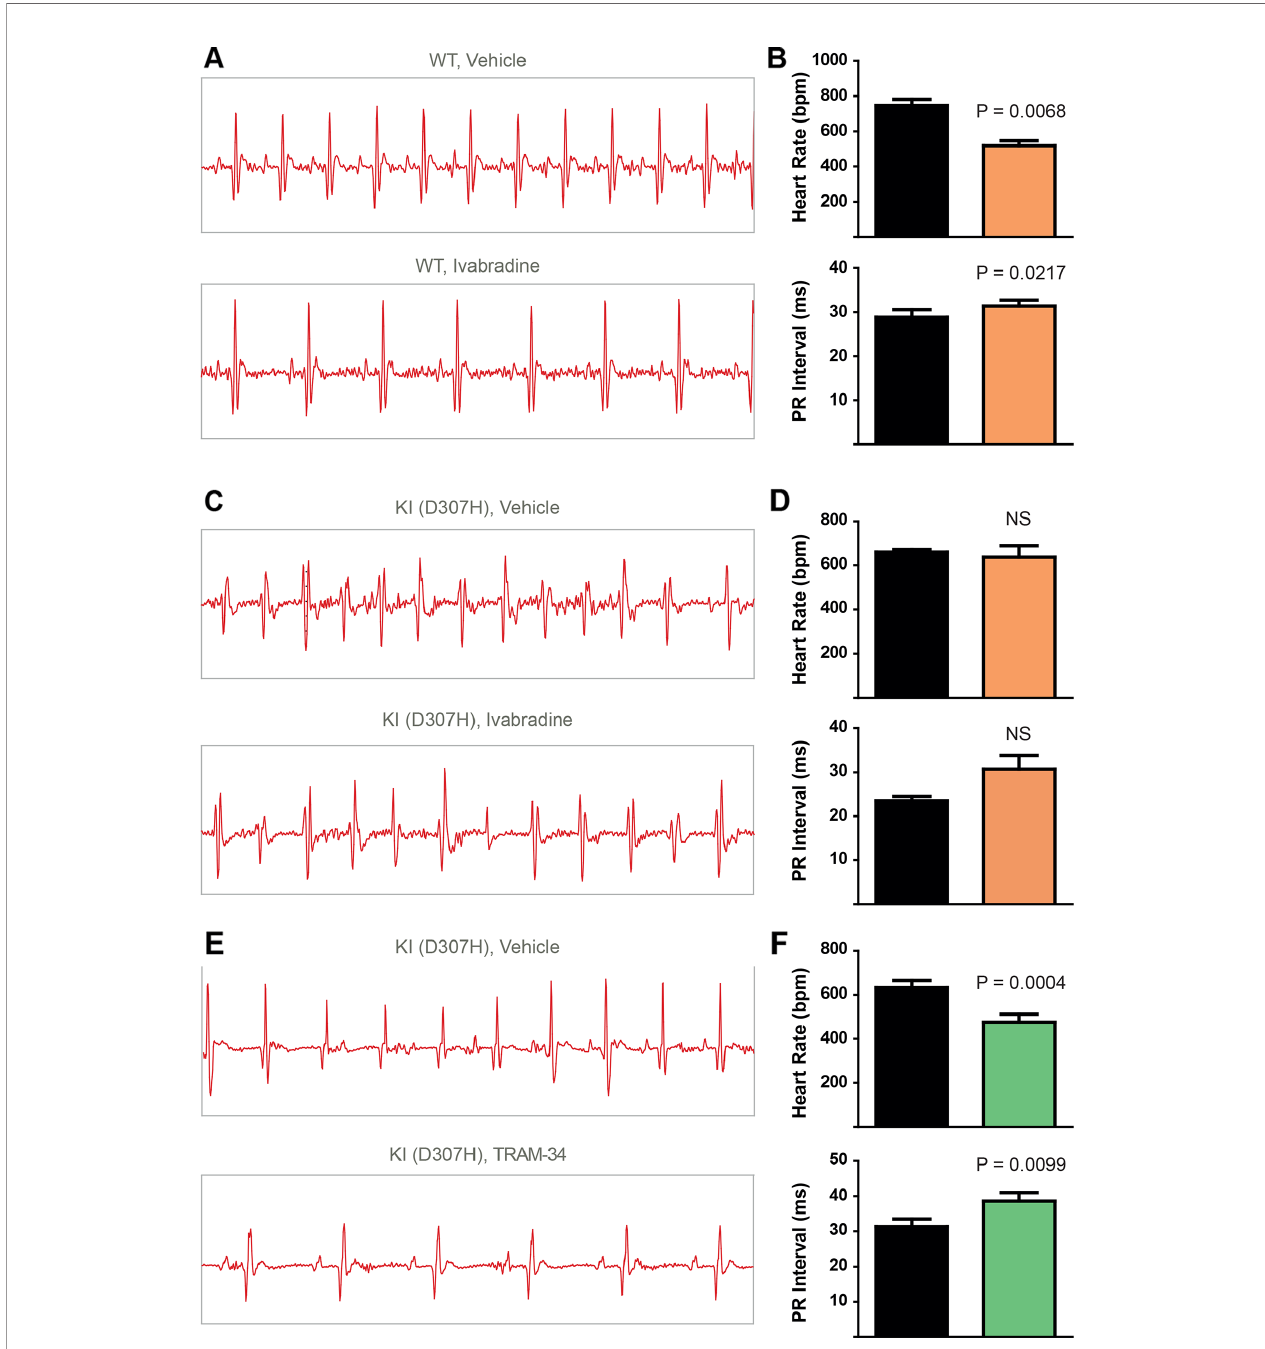
FIGURE 4 | In contrast to TRAM-34, ivabradine does not prevent the ventricular arrhythmias recorded in ECG from CASQ2 D307H KI mice following treadmill exercise. (A) Representative ECG recording following intraperitoneal (IP) injection of vehicle (saline, upper) and 6 mg/kg ivabradine (lower), in WT mice following treadmill exercise. (B) Data summary of heart rate (paired t test, n = 4, P = 0.0068) and PR interval (paired t test, n = 4, P = 0.0217) in WT mice after treadmill exercise and IP injection of ivabradine. (C) Representative ECG recording following IP injection of vehicle (saline, upper) and 6 mg/kg ivabradine (lower) in CASQ2 D307H knock-in (KI) mice following treadmill exercise. (D) Data summary of heart rate [not signi fi cant (NS), n = 4] and PR interval [not signi fi cant (NS), n = 4] after IP injection of ivabradine. (E) Representative ECG recording following IP injection of vehicle (peanut oil, upper) and 20 mg/kg TRAM-34 (lower) in CASQ2 D307H KI mice following treadmill exercise. (F) Data summary of heart rate (paired t-test; P = 0.0004, n = 11) and PR interval (paired t-test; P = 0.0099, n = 11) in CASQ2 D307H KI mice following treadmill